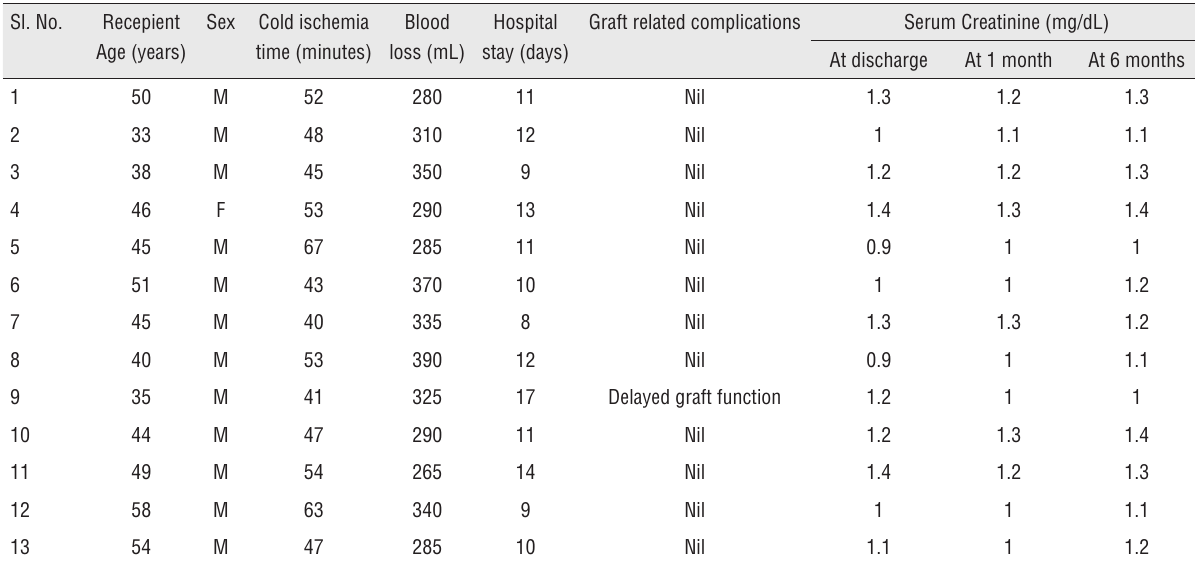
Table 2 - Recipient